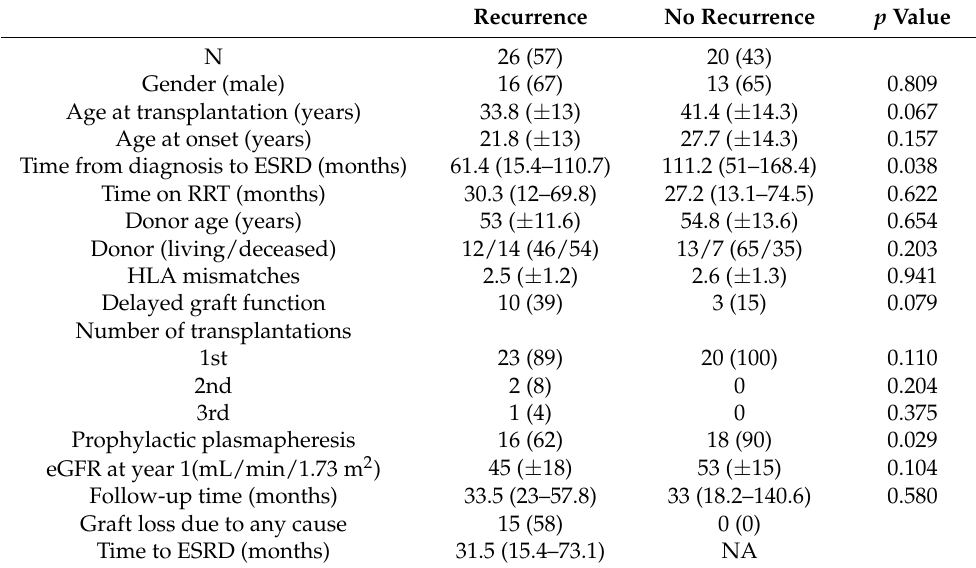
Table 1. Comparison of demographics and baseline characteristics between KTx recipients with and without focal segmental glomerulosclerosis (FSGS)recurrence in the graft.